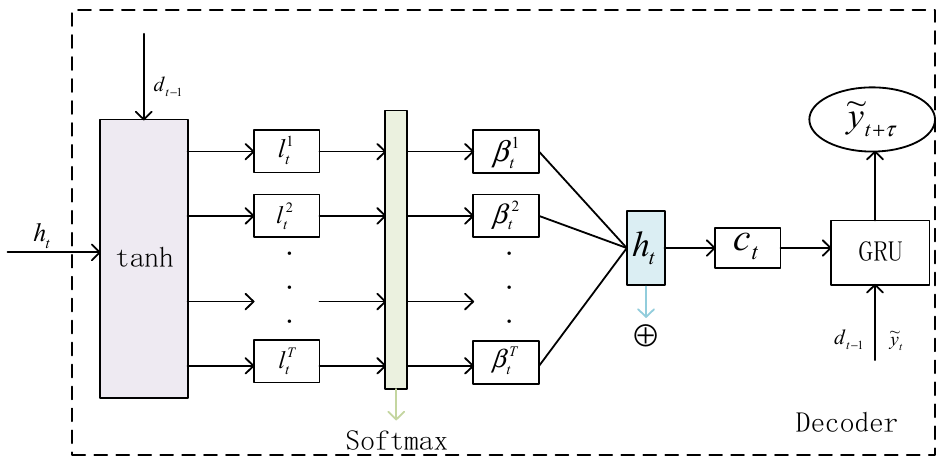
Figure 4. Decoding stage.